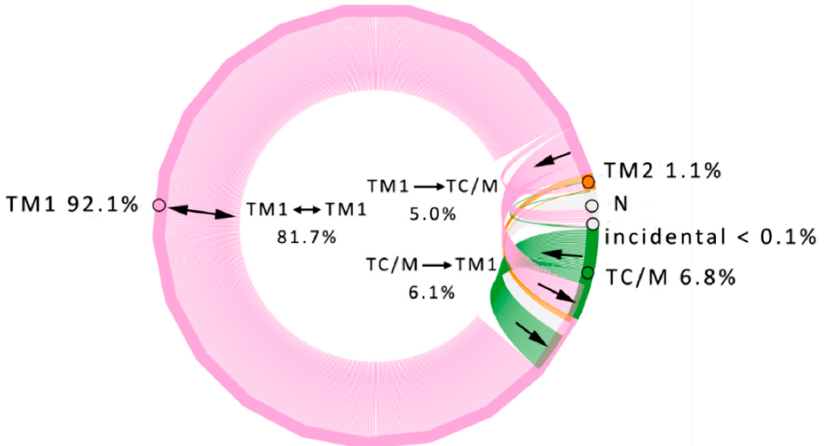
Figure 2. Water traffic in StEH1. The diagram shows the inter-relationships between identified inlet clusters. Clusters identified in all molecular dynamics (MD) simulations are presented as parts of the circle outline marked with consistent colour-coding: TM1—pink, TC/M—green, TM2—orange. The numbers outside the circle correspond to percentage ratios of inlets identified in particular clusters. N (grey) indicates ends of paths detected inside the protein and does not count for inlets percentage ratios. Lines inside the circle represent water paths coloured according to their entry cluster. Numbers inside the circle show ratios of water molecules travelling between annotated clusters. Please note that the largest number of water molecules enter and exit via single cluster (TM1 ↔ TM1, 81.7%). For pictures clarity, only most abundant paths (>2%, inner circle) are annotated with values and additional small arrows indicate flow direction.